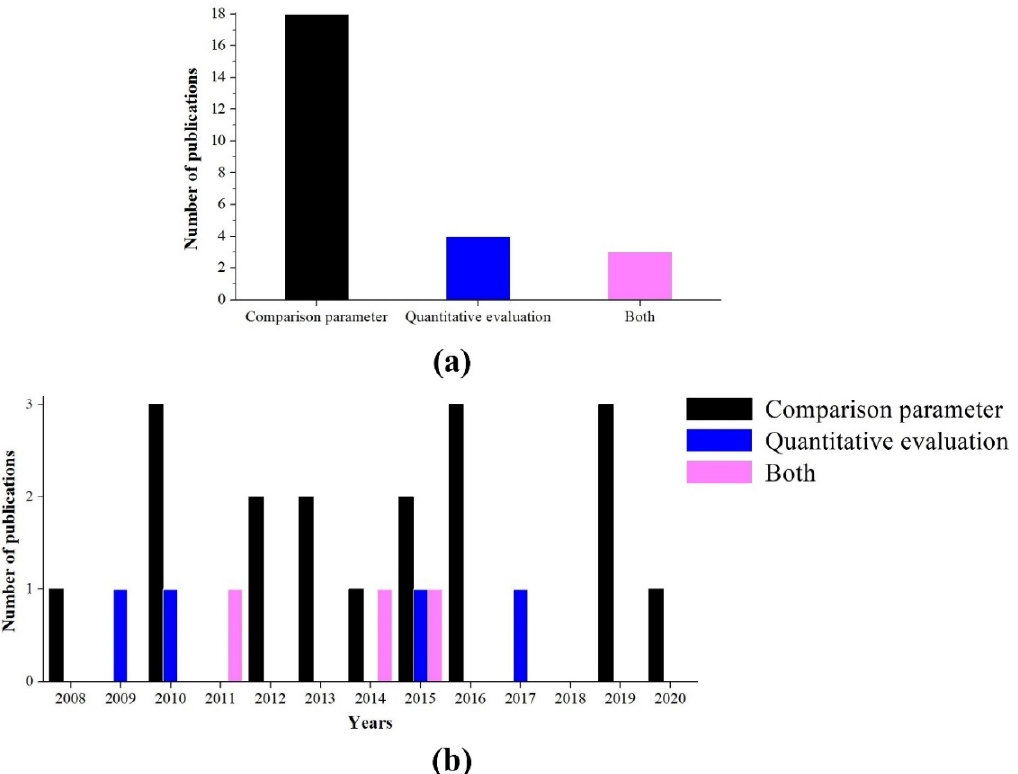
Figure 7. ( a ) Graph of the number of publications using MR imaging with the NLM noise reduction algorithm for various evaluation parameters. The final classification included 25 papers; of those, three major categories of techniques were investigated. ( b ) The total number of papers as a function of the publication year.